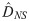
EU-emails: Normalized temporal differences for the NetSimile distance D^NS and edit distance D^E.